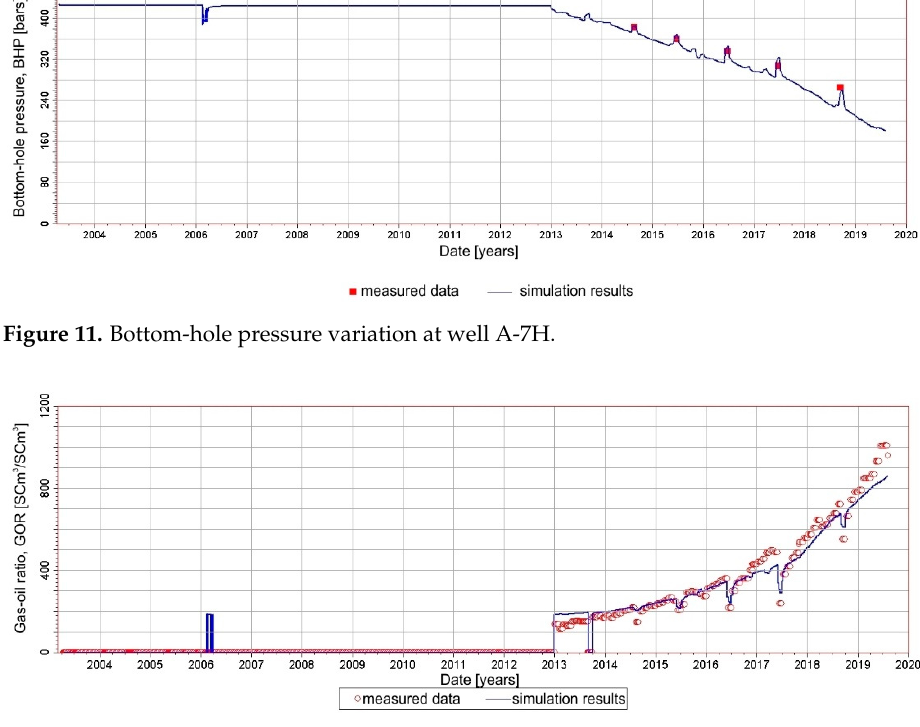
Figure 12. Gas–oil ratio (GOR) variation at well A-7H.